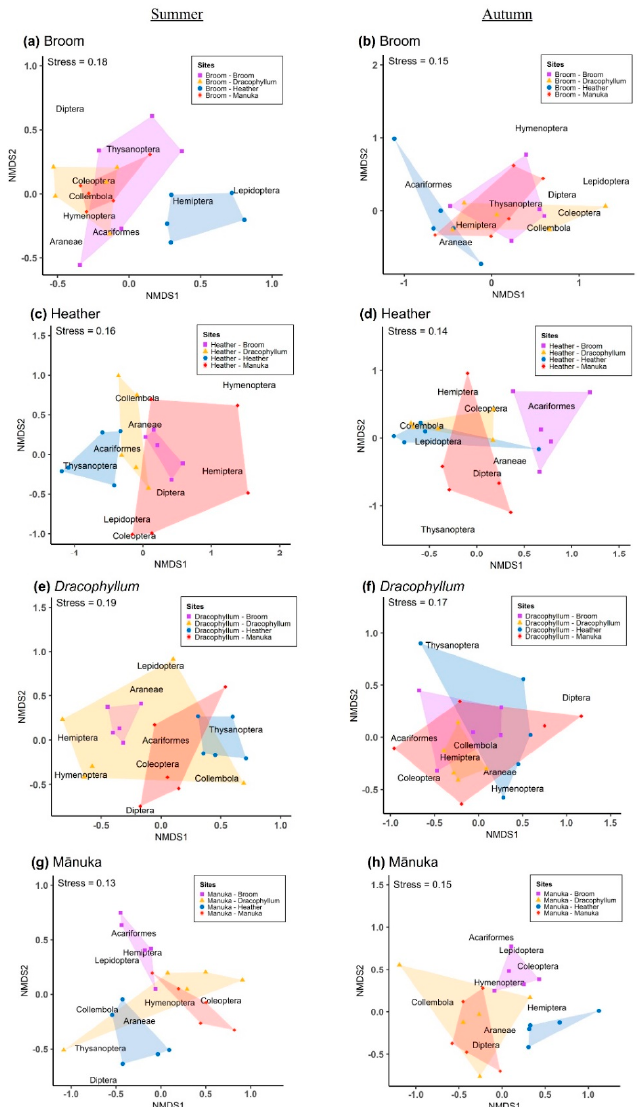
Figure 2. Non-metric multidimensional scaling (NMDS) plots showing the arthropod community composition on ( a, b ) broom, ( c, d ) heather, ( e, f ) Dracophyllum, and ( g, h ) m ā nuka paired with different plants in summer and autumn. Arthropods collected by the beating tray method ( n = 5 for each group).